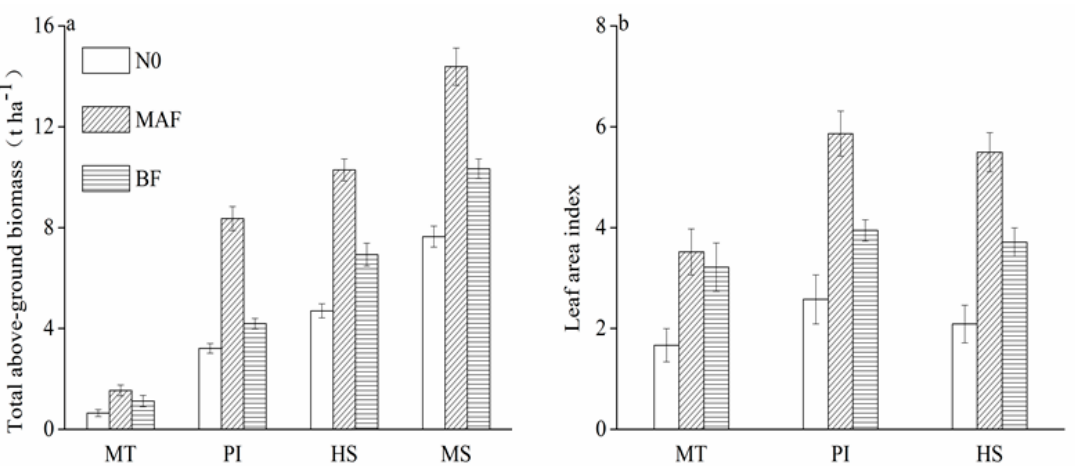
Figure 2. Effects of mechanical deep placement of nitrogen fertilizer on average for the total above-ground biomass and leaf area index for both rice cultivars (2018 and 2019). ( a ):